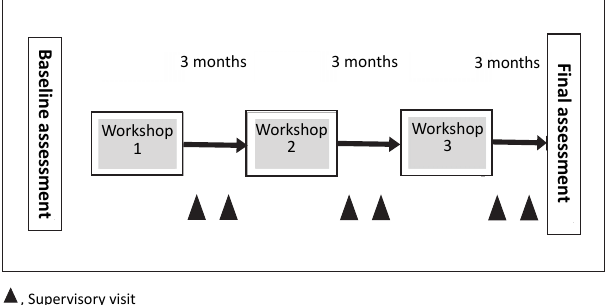
FIGURE 2: Strengthening Laboratory Management Towards Accreditation (SLMTA) Cohort 2 implementation model. FIGURE 2: Strengthening laboratory management towards accreditation (SLMTA) Cohort 2 FIGURE 2: Strengthening laboratory management towards accreditation (SLMTA) Cohort 2 FIGURE 2: Strengthening laboratory management towards accreditation (SLMTA) Cohort 2 FIGURE 2: Strengthening laboratory management towards accreditation (SLMTA) Cohort 2 FIGURE 2: Strengthening laboratory management towards accreditation (SLMTA) Cohort 2 implementation model. implementation model. implementation model. implementation model. implementation